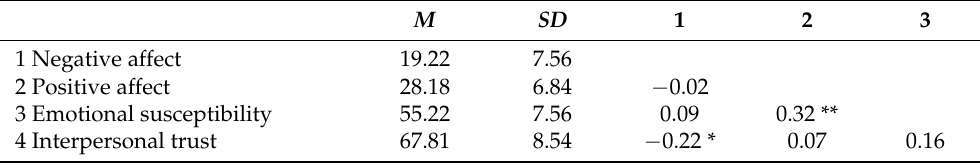
Table 3. Descriptive data and correlations of the